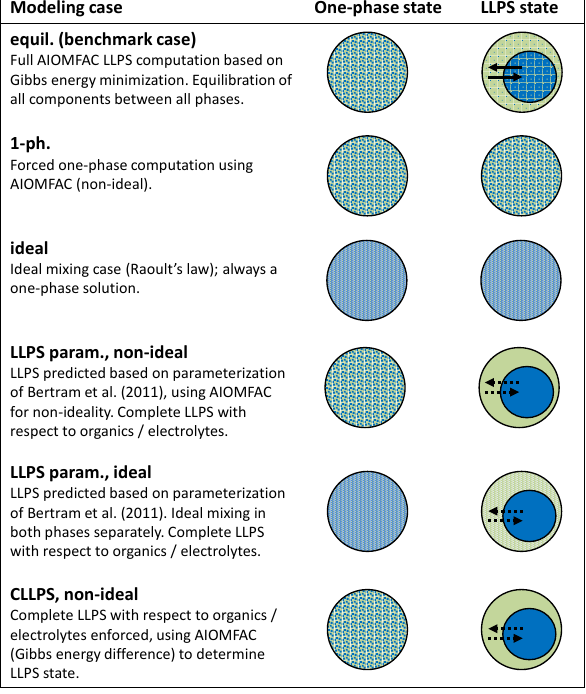
Fig. 1. Overview of the different PM modeling cases used in the gas- particle partitioning calculations. In the situation of a liquid-liquid phase separation (LLPS), all components are allowed to partition between coexisting phases in the equilibrium case (solid arrows), while for the two different LLPS parameterization cases and the CLLPS case a complete phase separation is assumed with respect to organic compounds and electrolytes, i.e. complete separation into an aqueous organic phase and an aqueous electrolyte phase, with liquid-liquid equilibration of water only (dashed arrows). The gas phase is in all cases an ideal gas mixture equilibrating with the over- all